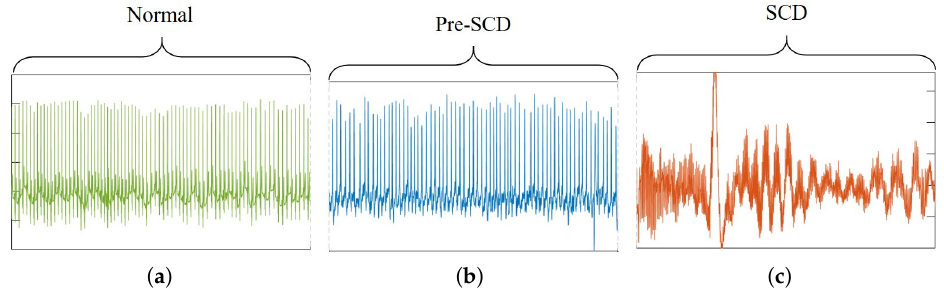
Figure 5. Comparison of segments from ECG signals: ( a ) normal, ( b ) pre-SCD, and ( c ) during SCD.